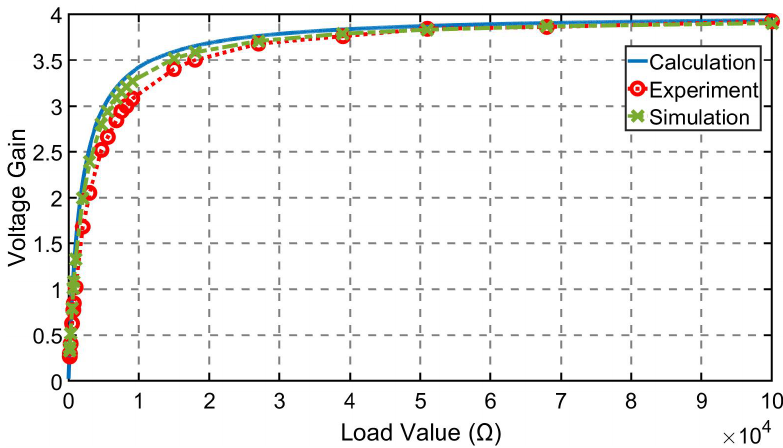
Figure 10. Comparison of the calculated, simulated, and experimental voltage gains at different load values.